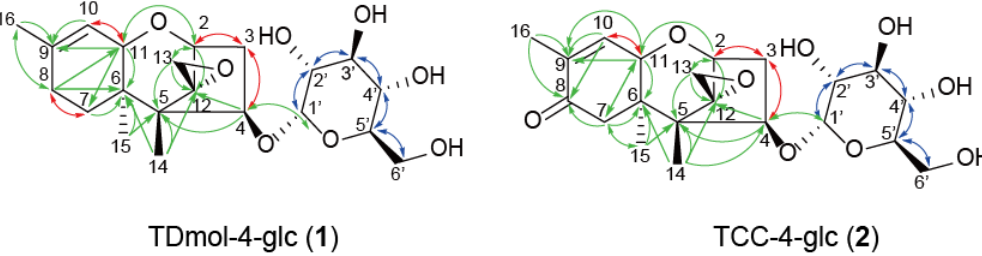
Figure 3. Determination of the structures of d-type trichothecenes 1 and 2 . The red, blue, and green arrows indicate 1 H– 1 H correlation spectroscopy (COSY), total correlation spectroscopy (TOCSY), and heteronuclear multiple bond coherence (HMBC) correlations, respectively.